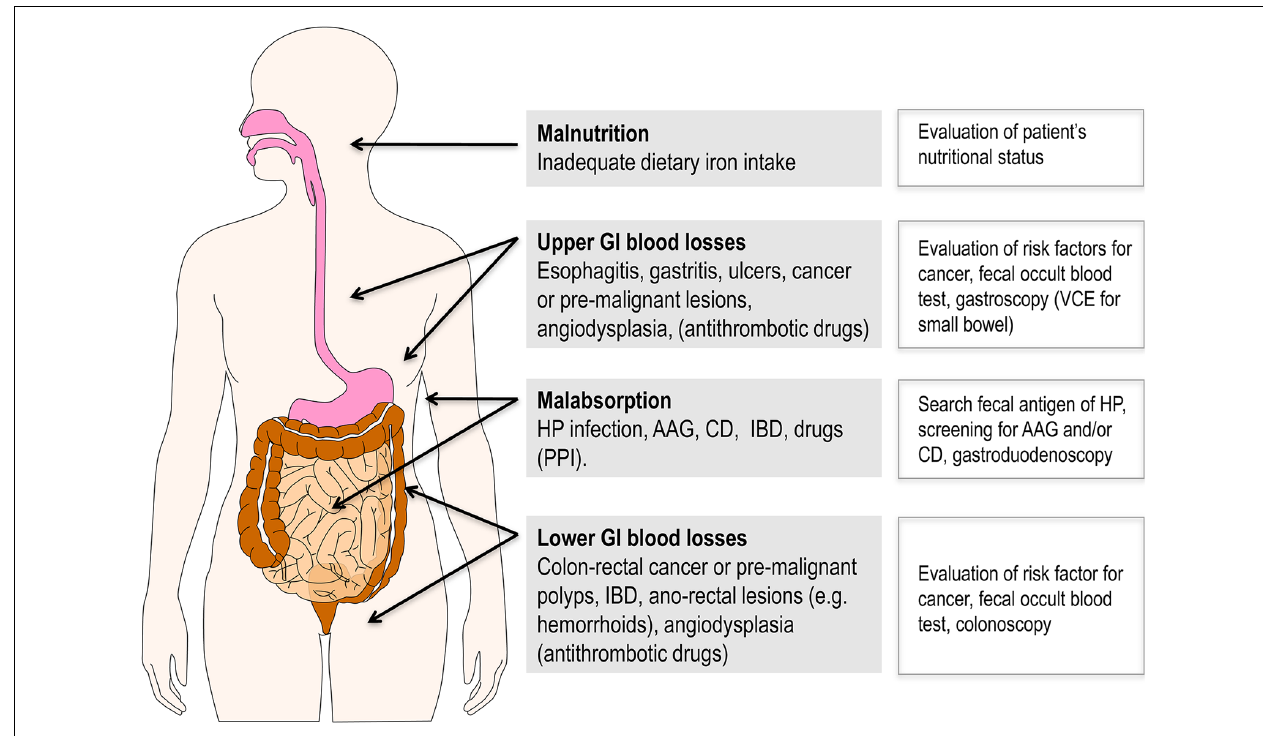
FIGURE 1 | Gastrointestinal diseases representing the most frequent causes of ID and IDA in elderly patients. Of note, more than one of these conditions not infrequently coexist in a given individual. Bleeding is often favored by antithrombotic drugs for treatment of cardiovascular diseases that